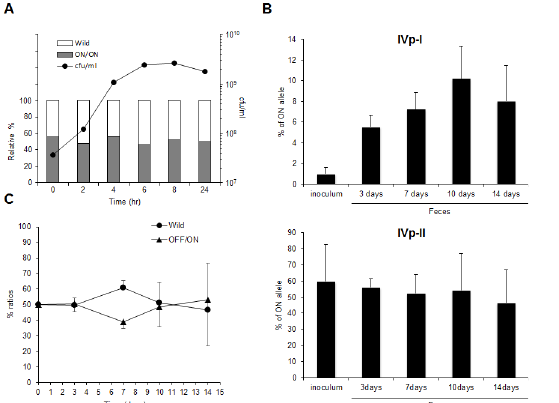
Fig 9. Comparative analysis of the in vitro and in vivo growth of IVp-I/IVp-II-locked mutants. (A) Competitive growth assay of ON/ON B . fragilis mutant and its parental YCH46 stain in vitro . Equivalent cell mixture of wild and mutant B . fragilis cells was inoculated into GAM broth. Closed circles indicate the periodical change of total viable cell number in GAM broth. Columns indicate the relative abundance of the wild and mutant B . fragilis cell in GAM broth. (B) IVp-I/IVp-II ON/OFF prevalence during in vivo gut colonization IVp-I/IVp-II under in vivo gut colonization by B . fragilis . A cell suspension (7.0 x10 7 CFU in total) of wild-type B . fragilis was inoculated into three 8-week-old male BALB/cA germ-free mice via gavage. At 3, 7, 10, and 14 days after inoculation, feces samples were collected. DNA was extracted from the initial inoculum and the collected feces samples, and the ON/OFF ratio of IVp-I/IVp-II in each sample was determined by qPCR. The data are expressed as means ± standard deviation. The bars labeled with different letters indicate significant differences at p < 0.05. (C) Competitive growth assay of IVp-I/Vp-II-locked B . fragilis mutant and its parental YCH46 stain. Equivalent cell mixture of wild and the OFF/ON mutant cells was inoculated into